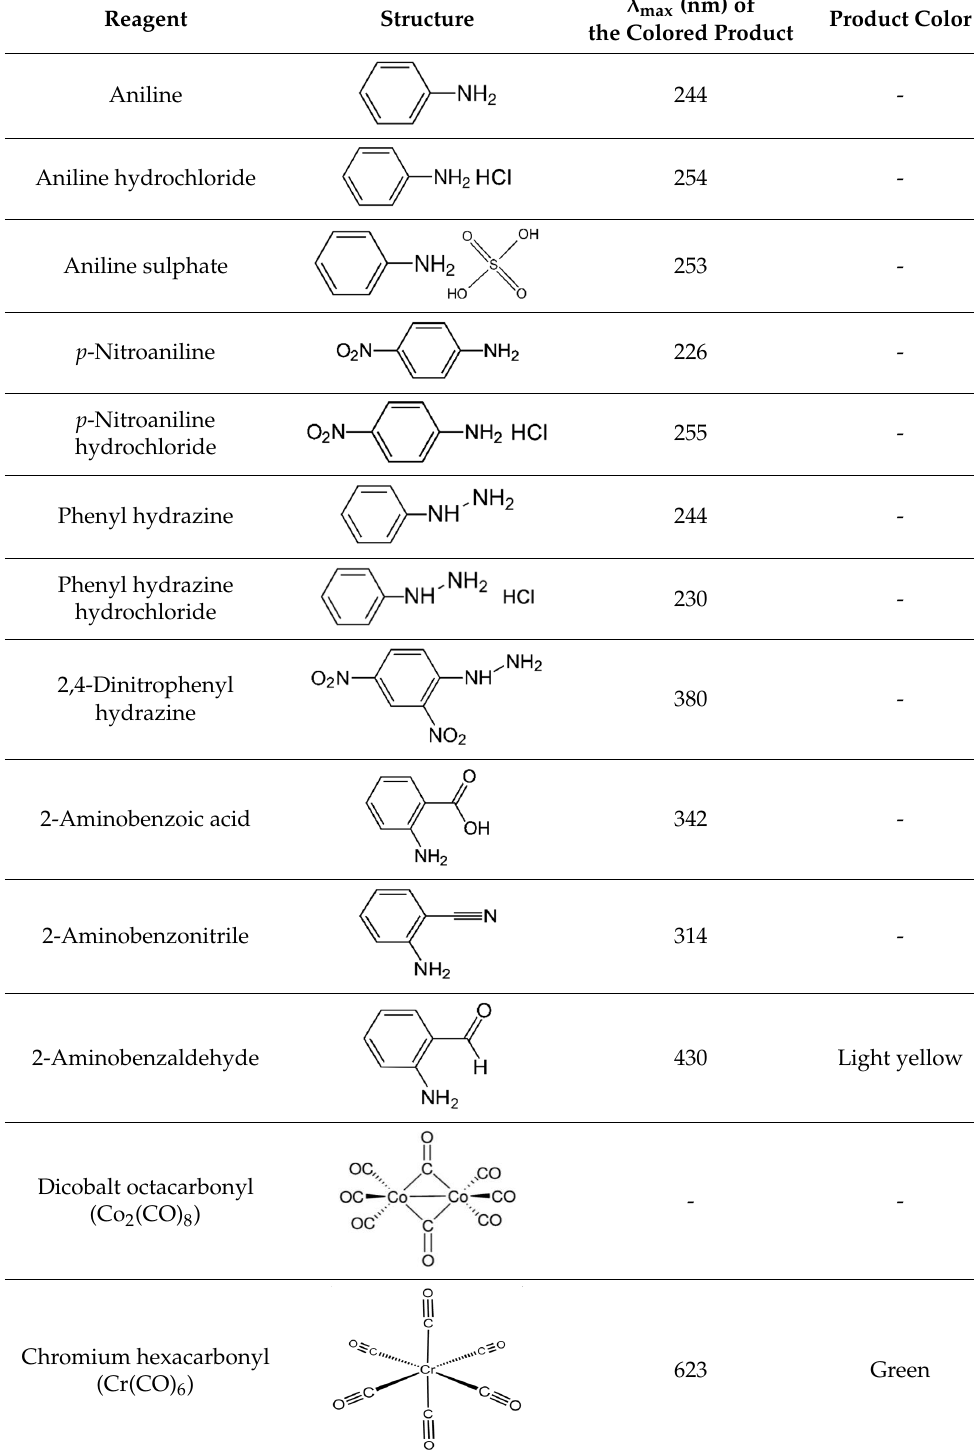
Table 1. Reagents reacted with 2AP for the study of colored products.